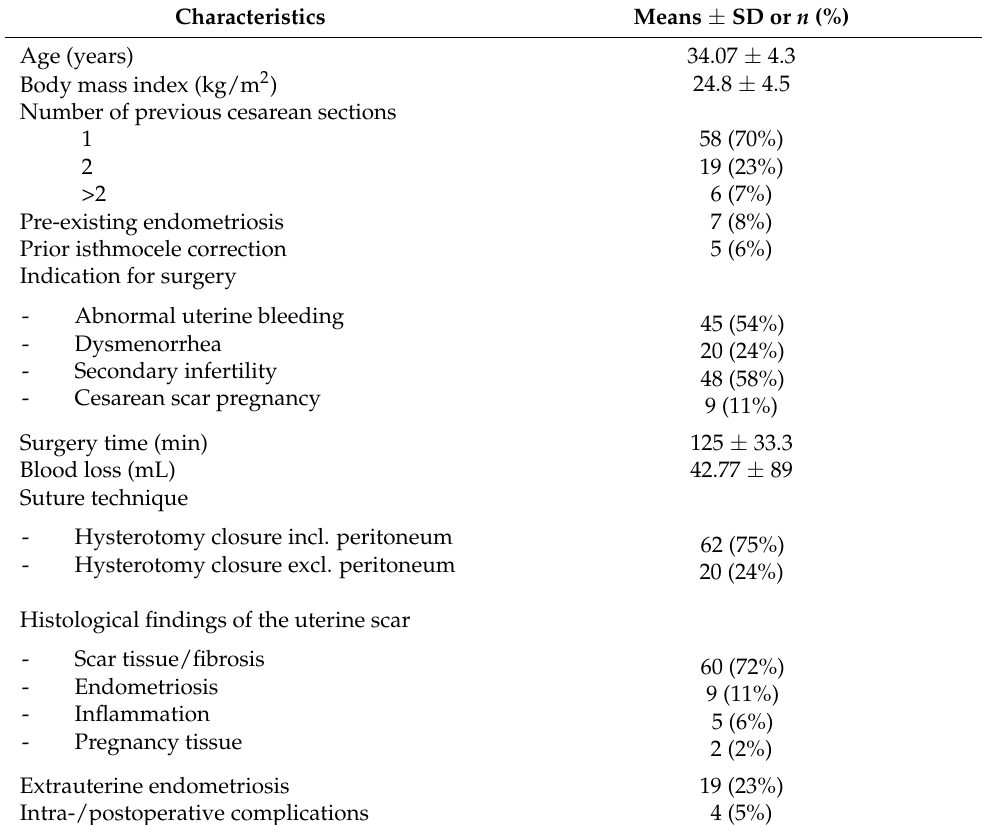
Table 1. Descriptive and surgery characteristics of the study population, n =